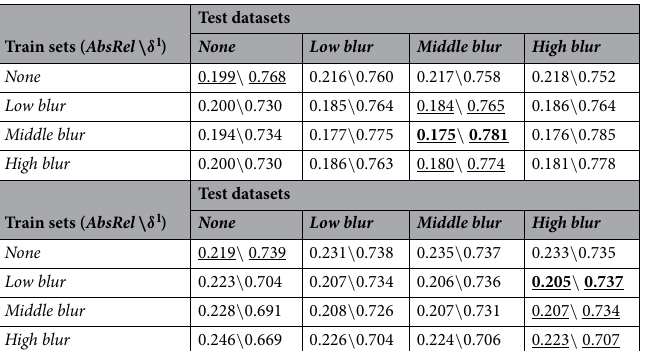
Table 7. Motion blur test in monodepth2-3D (up) and monodepth2-3Ds (down). The best result in each row is underlined and the optimal result is bolded.